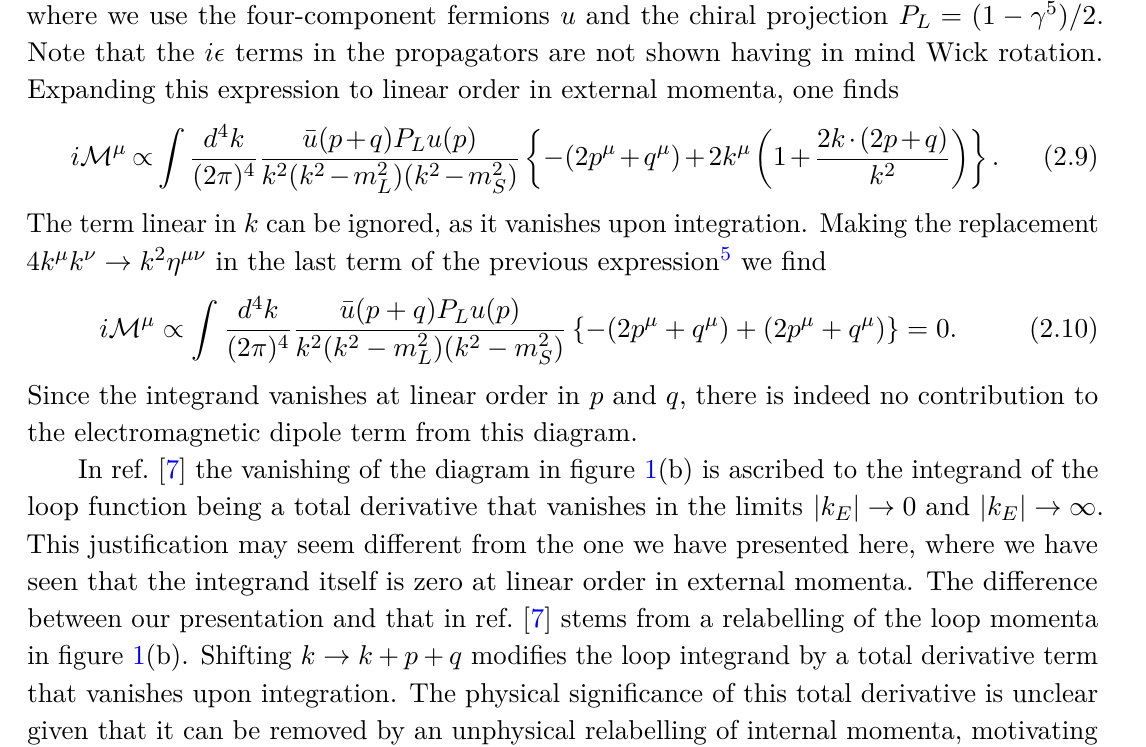
= 0 . V Y Y 0∗ L R V